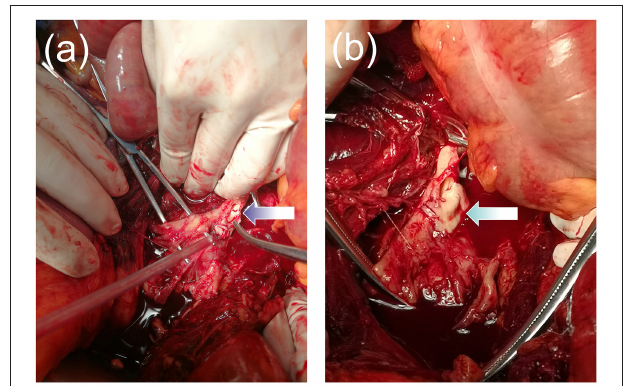
FIGURE 1 | (a,b) Image showing the aneurysm rupture at the abdominal aortic bifurcation. The wall of the aorta was severely lacerated with a thin and irregular